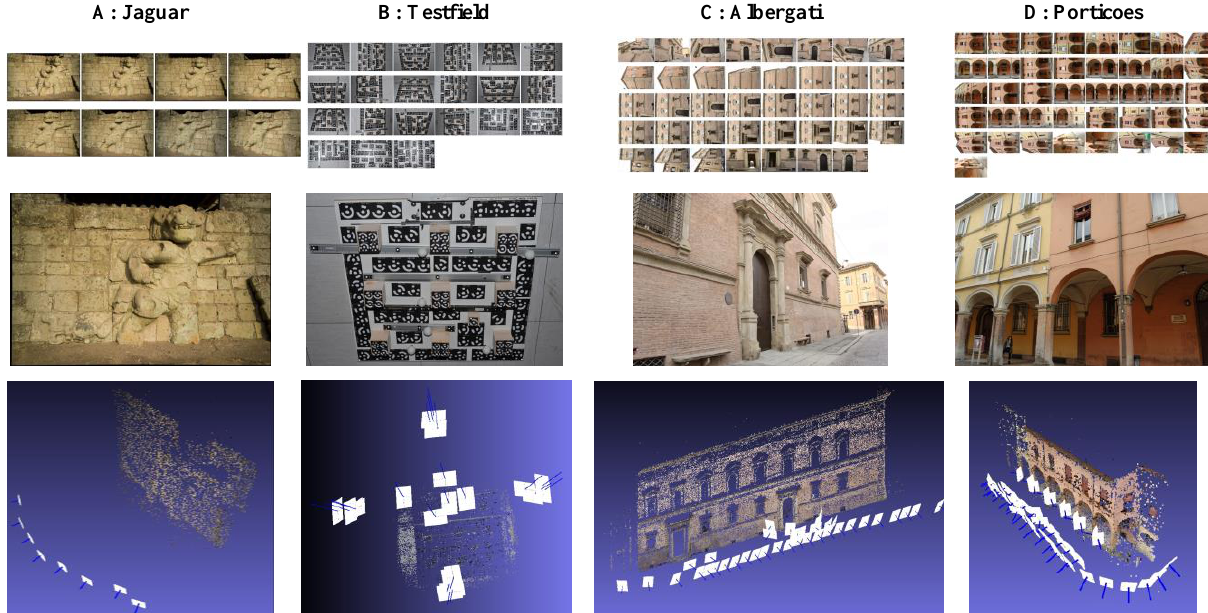
Figure 1: The employed datasets with their images and different camera networks: Jaguar (A), Testfield (B), Albergati (C), Porticoes (D). They feature high-resolution images, convergent acquisitions, variable image overlap, camera rolls, flat and textureless surfaces as well as repeated patterns and illumination